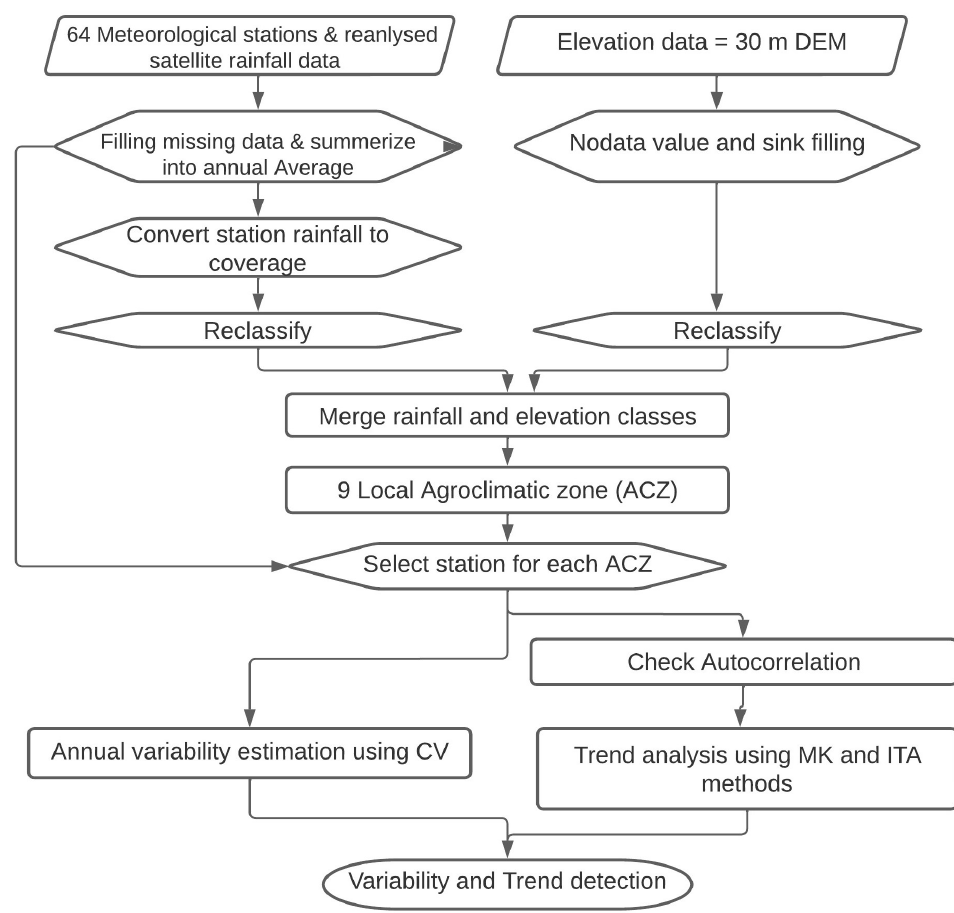
Figure 3. Flowchart showing the methodology of the